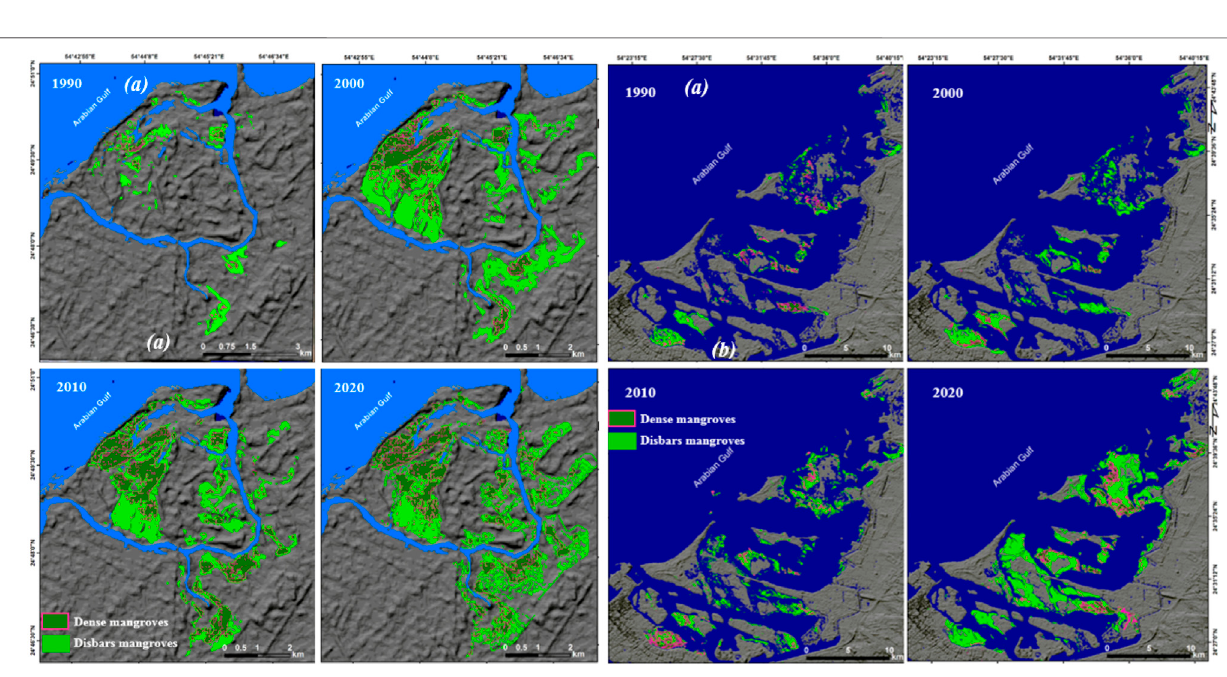
Frontiers in Remote Sensing |